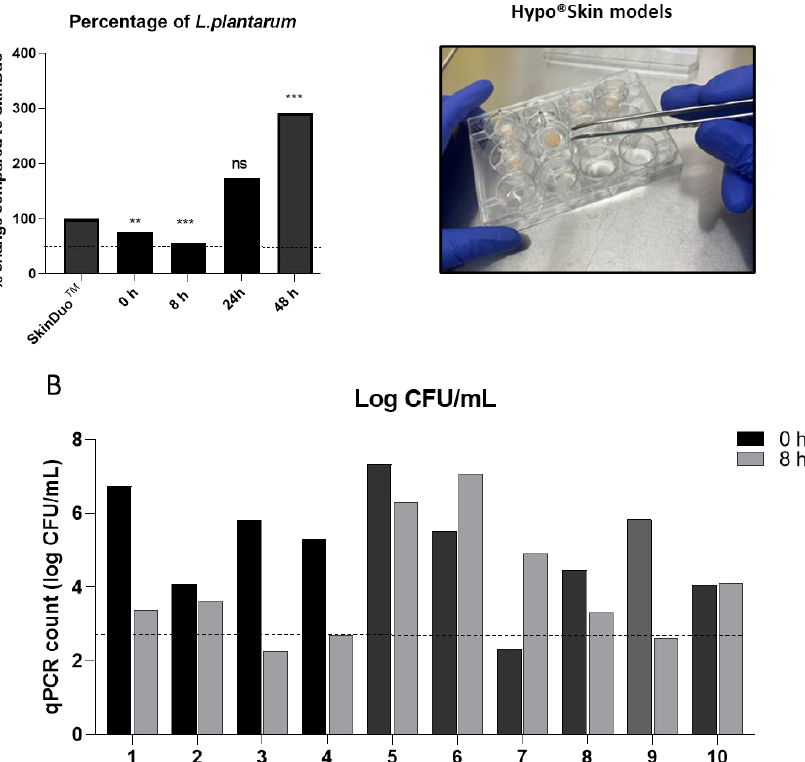
Figure 2. Viability of SkinDuo TM on the skin. ( A ) The serum SkinDuo TM was topically applied to skin biopsies (right picture) and tested for viability at times 0, 8 h, 24 h and 48 h, and compared as a percentage change to serum SkinDuo TM (left graph). CFU/mL was counted in technical triplicates. The mean for each time-point is presented. From time 8 h to time 48 h, there is a doubling increase of L. plantarum survival which increases steadily over time. This long-term viability increases the action of L. plantarum , without any damage on the skin. The experiment was repeated twice. For time 24 h, the repeated experiment resulted in an increased trend, ns p > 0.05 (Supplemental Data Table S2). Statistical comparison (CFU/mL): serum Vs. 0 h, 8 h, 24 h, 48 h; NS. p > 0.05;